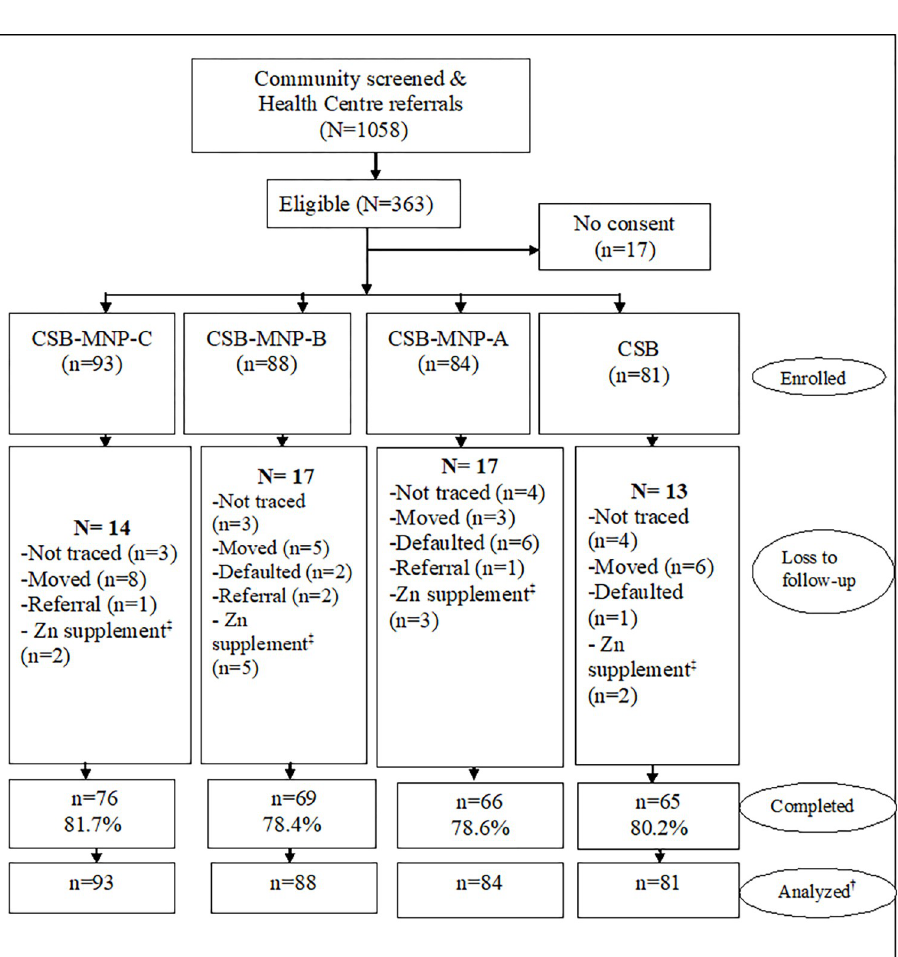
Fig 1. Trial profile. ‡ Received therapeutic zinc dose from health facility; † All participants were analyzed based on treatment assignment regardless of adherence and drop-out status.